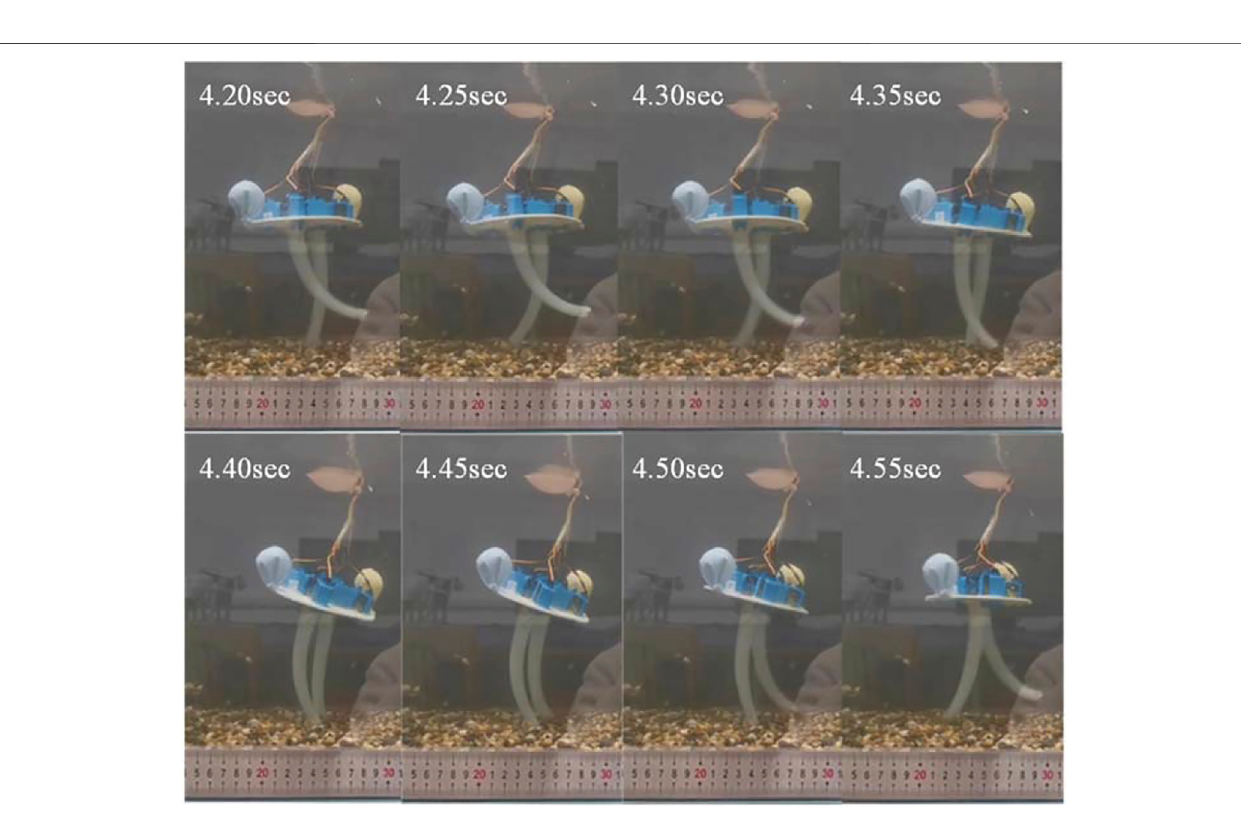
motion during the straight walking process, that is, eight motion cycles. Affected by the uneven height of the sandy ground, the average peak-to-peak value of the robot ’ s center of mass fl uctuation increases to 0.95 cm. Affected by the resistance of